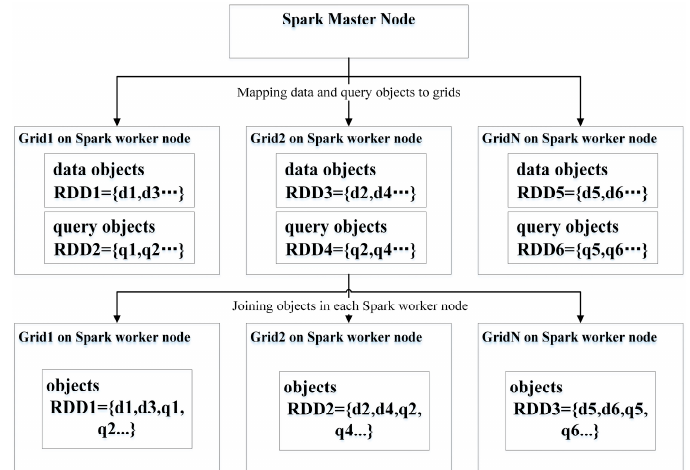
Figure 2. The execution flow of Spark-based spatial join query (SJQ) algorithms. Data and query objects are partitioned and stored in grids according to their spatial location. Spark executors on Spark worker nodes would do spatial overlap predicate computation after the joining transformation tasks are received from the Spark Master instance.